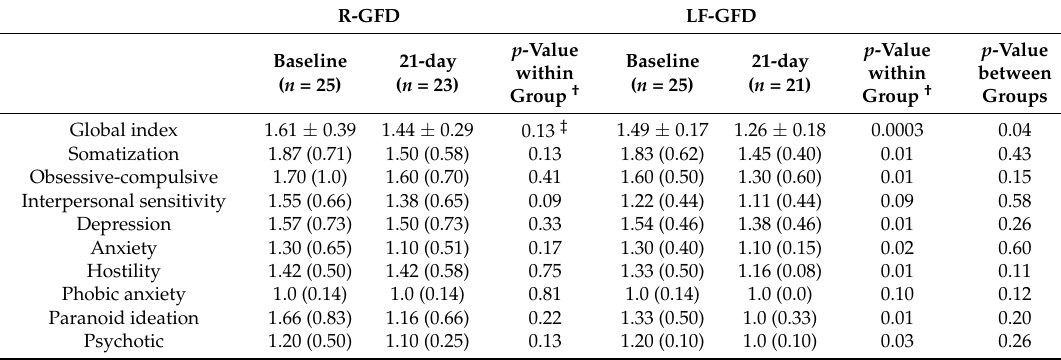
Table 3. SCL-90 scores according to studied groups 1